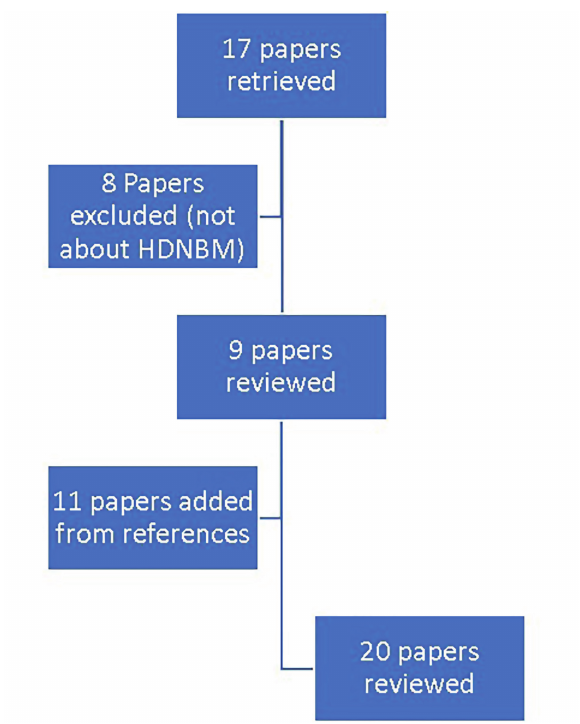
Figure 1: PRISMA diagram describing literature review